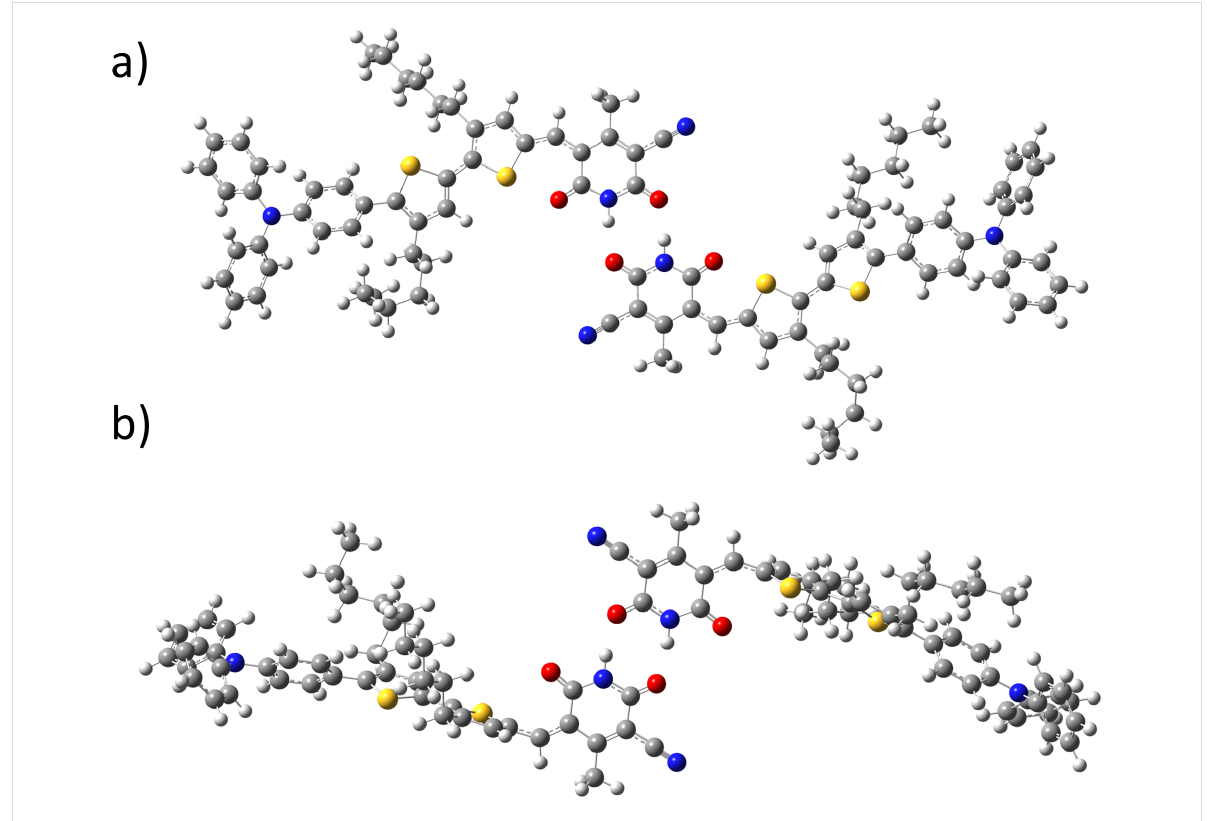
Figure 5: Dimeric structures of 2 . (a) centrosymmetric dimer of 2 ; (b) bond-rotated centrosymmetric dimer of 2 as predicted by DFT calculations.